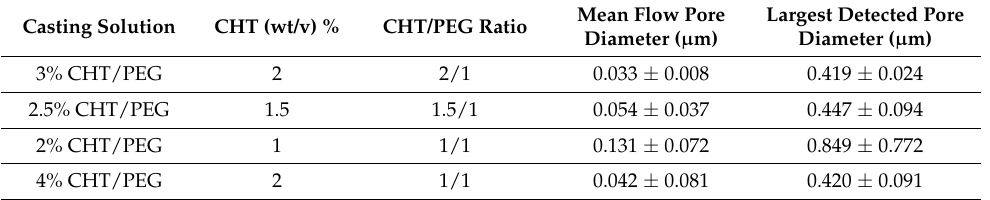
Figure 1. SEM pictures of top surface ( a ) and cross-section ( b ) of nanoporous chitosan membrane. Microporous membranes were prepared by dissolving CHT and PEG Mw 10,000 Da as porogen in a different (wt/v) % and ratio in the casting solution, as reported in Table 1. After the evaporation-induced phase separation process, the porogen was dissolved in a water bath at 80 ◦ C. This treatment allowed the selective removal of PEG while keeping the polymer structure unaltered, since chitosan is stable at this temperature as known from thermogravimetric curve of the polymer (with 94% degree of deacetylation) [18,19]. After extensive washing and the drying process, microstructured membranes with a thickness of 22.6 ± 0.1 µ m were obtained. Composition of the casting solutions in terms of chitosan (CHT) (wt/v) % and CHT/polyethylene glycol (PEG, Mw 10,000 Da) ratio, for the development of different microstruc- tured CHT membranes, and corresponding values of the membrane open pores diameters detected by Capillary Flow